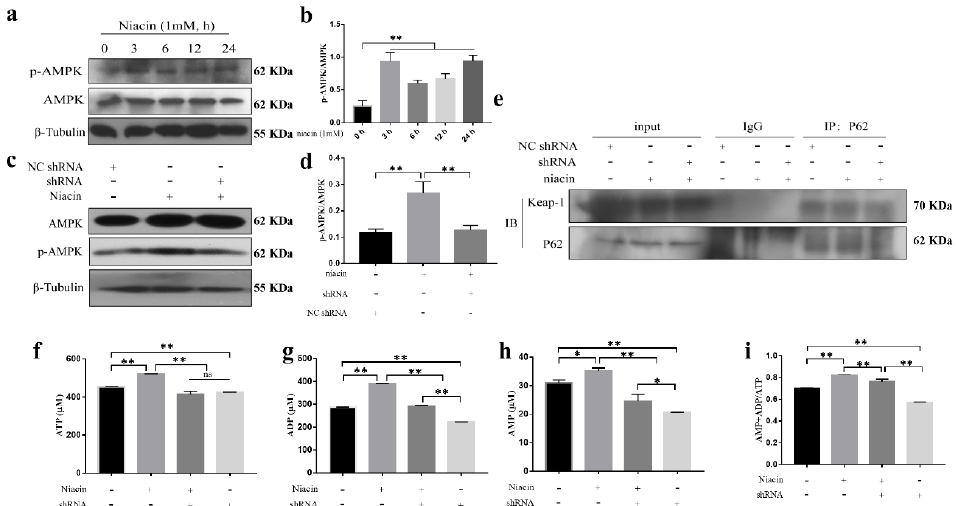
Figure 4. GPR109A regulates energy metabolism, AMPK phosphorylation, and P62 interact